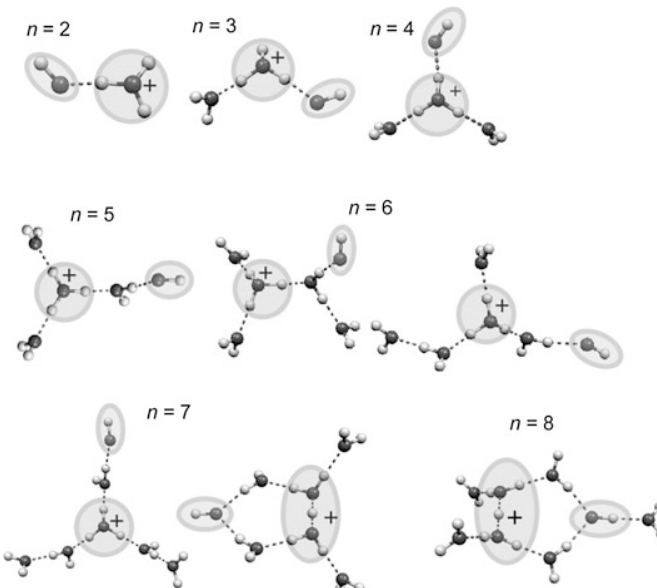
Figure 29. Experimentally characterized cluster structures of (H 2 O) n + • . Figure adapted from [50] with permission. Copyright 2013 Springer Nature.